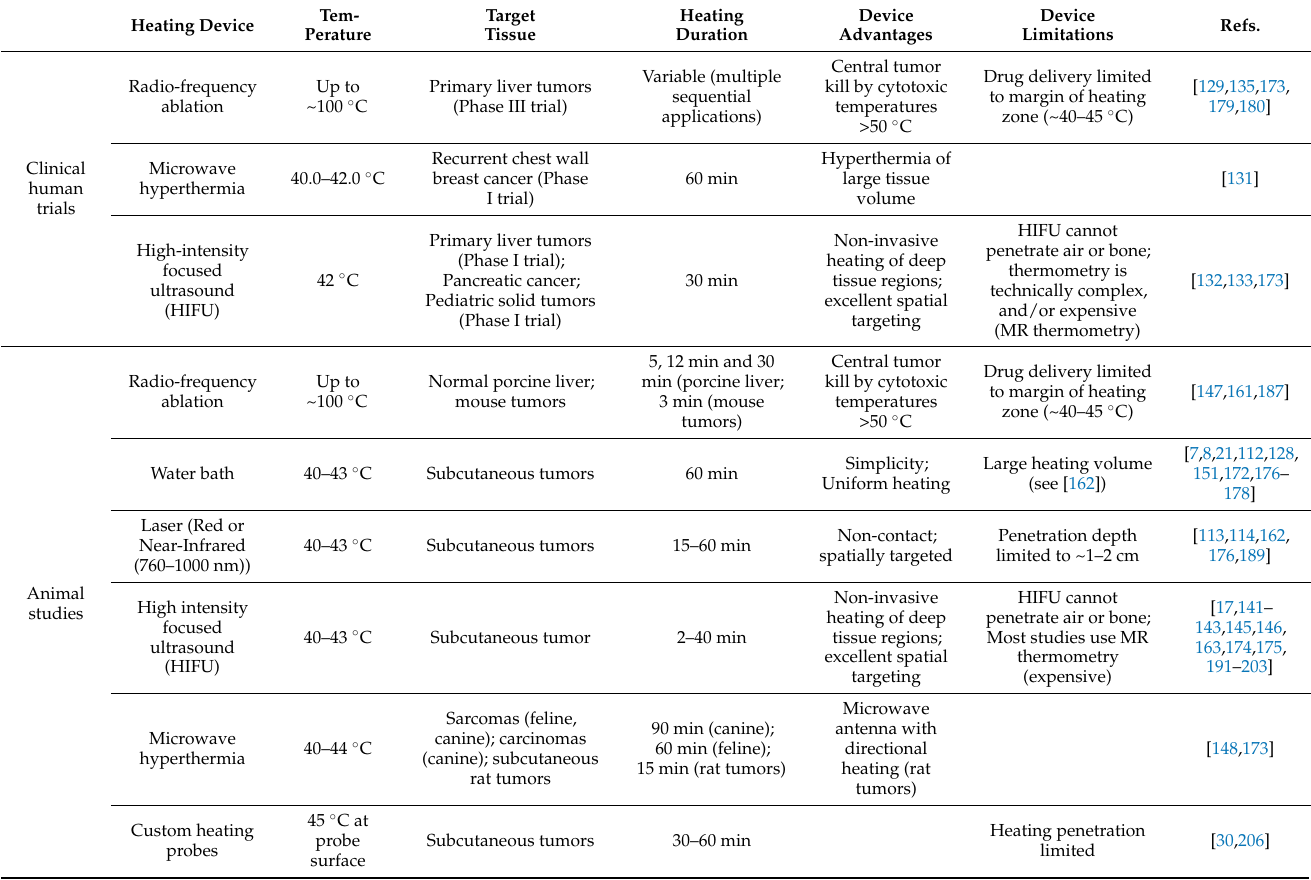
Table 3. Heating devices used in human and animal studies with